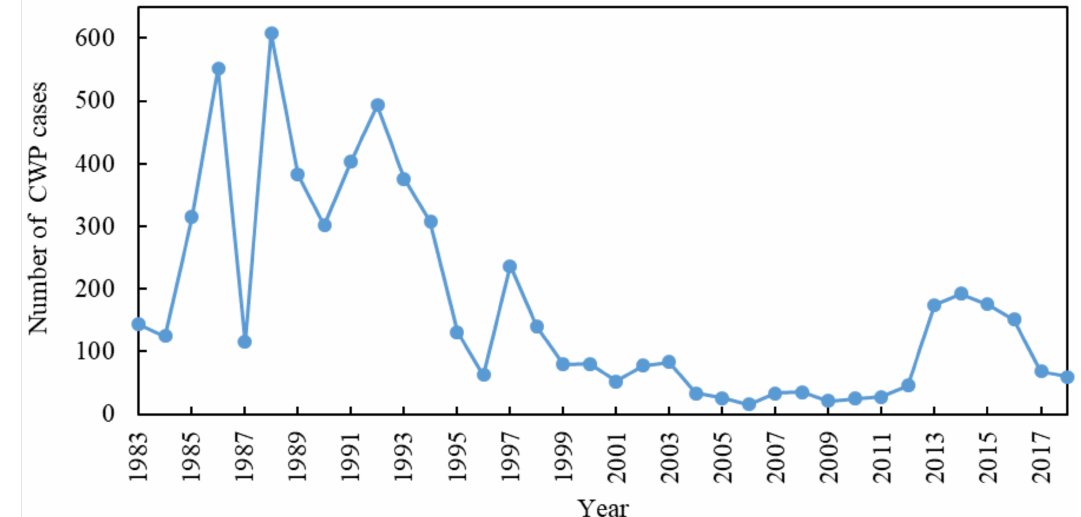
Figure 2. Number of reported CWP in the United States underground coal mines from 1983–2018 (Data is extracted from Accident/Injury/Illness Files of MSHA, see https://arlweb.msha.gov/OpenGovernmentData/OGIMSHA.asp (accessed on 27 June